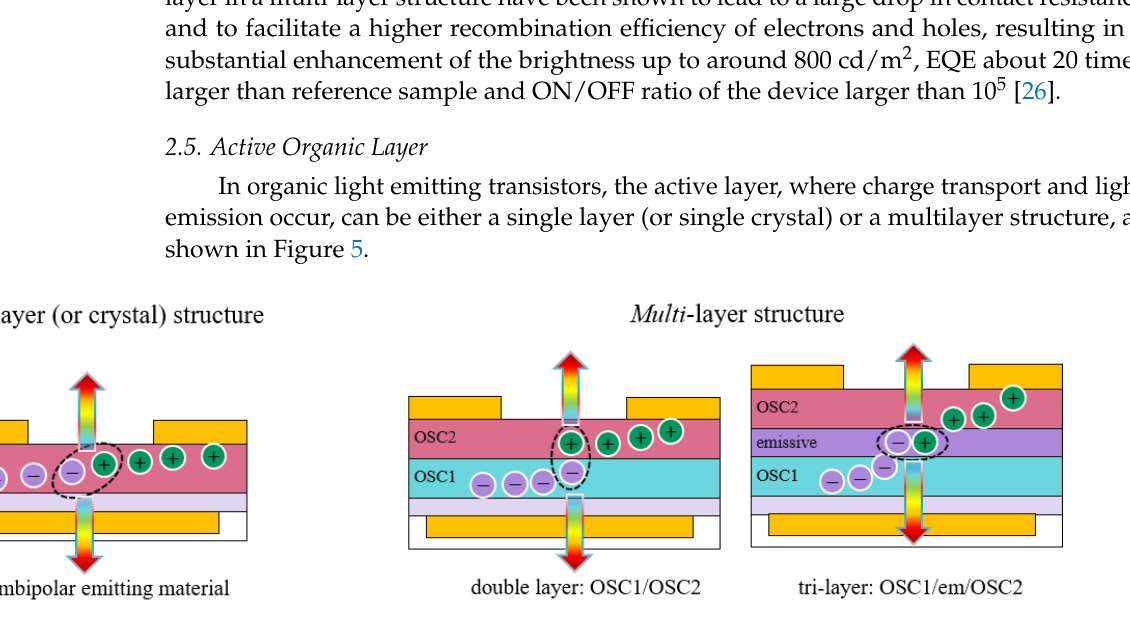
Figure 5. OLET: single vs. multi-layer structure. ( Left ) single-layer (or crystal) organic light emitting transistor, where a single material is responsible for both charge transport and light emission, while ( right ) multi-layer structure includes two or more layers, with each layer being intended for transport and/or light